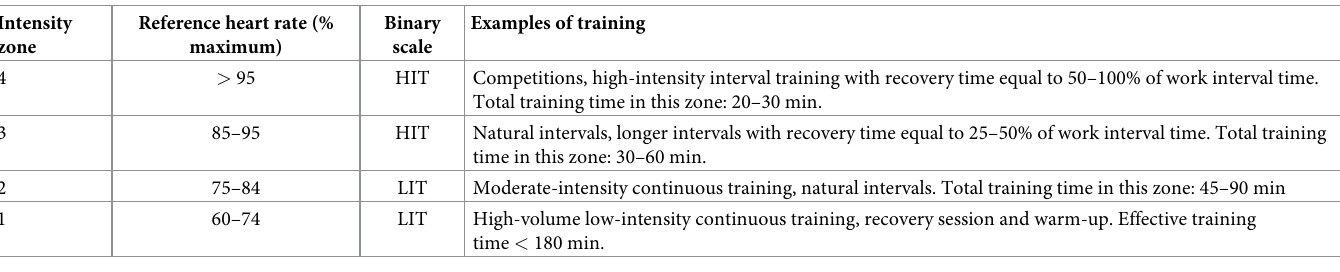
Table 1. The 4-zone intensity scale used by the Swedish Ski Association and the binary intensity scale used for categorization of endurance training in the current study. Intensity Reference heart rate (% zone